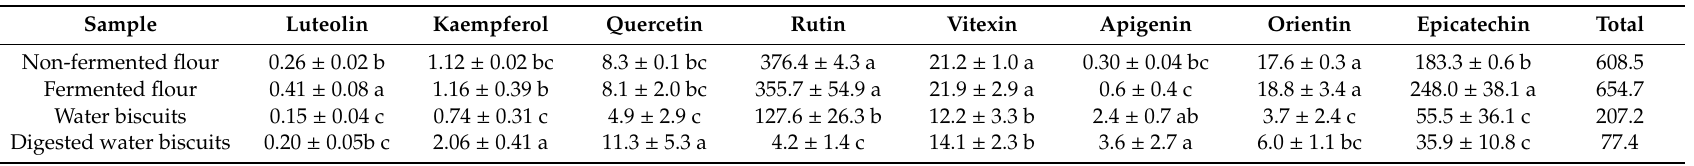
Table 4. Average levels of flavonoids ( µ g / g) in non-fermented buckwheat flour, fermented flours, and water biscuits before and after in vitro